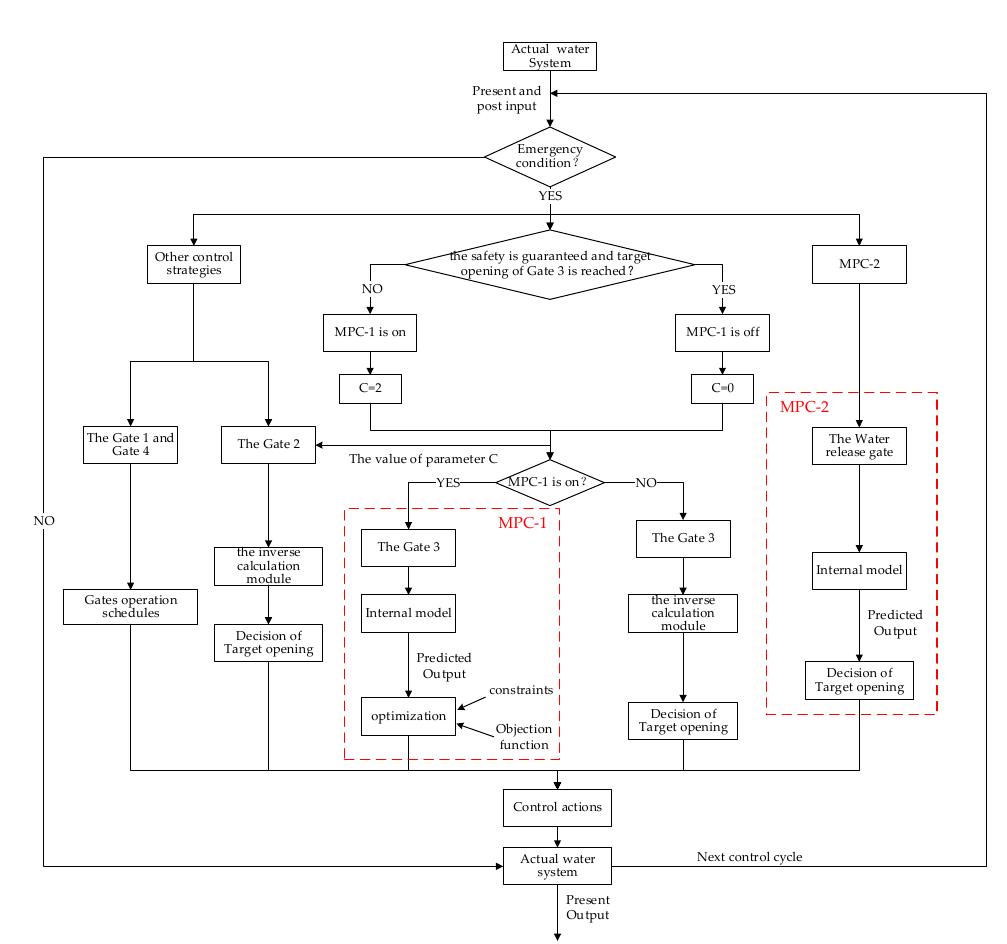
Figure 3. Schematic overview of the control system.